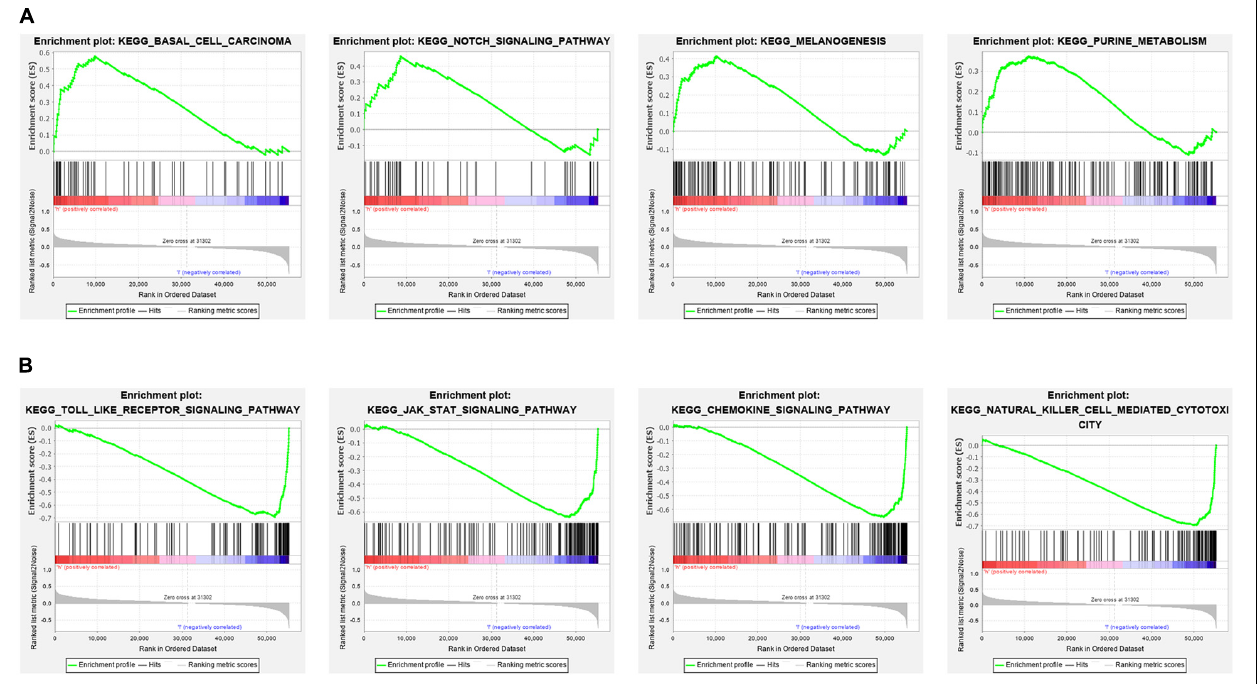
FIGURE 9 | Gene set enrichment analysis (GSEA) for the signature based on RBPs. (A) Enriched KEGG pathways in the high-risk group. (B) Enriched KEGG pathways in the low-risk group.